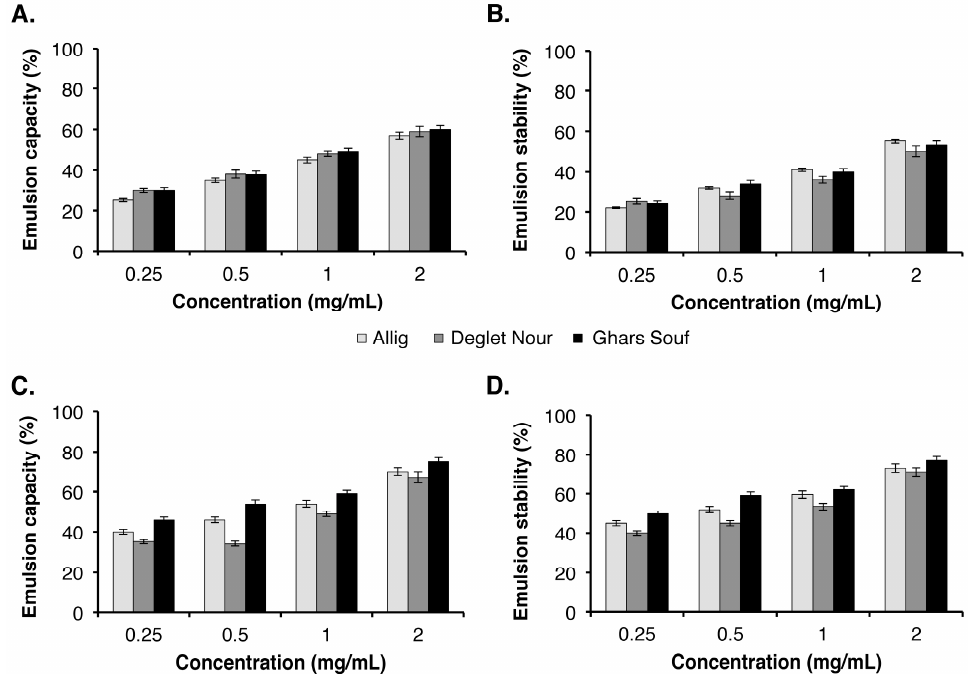
Figure 2. Emulsifying capacity and stability of DSP ( A , B ) and DSH ( C , D ) at di ff erent concentrations. Each value represents the average of three biological replicates ± standard deviation (SD). DSP, date seed polysaccharides; DSH, date seed hemicellulose.